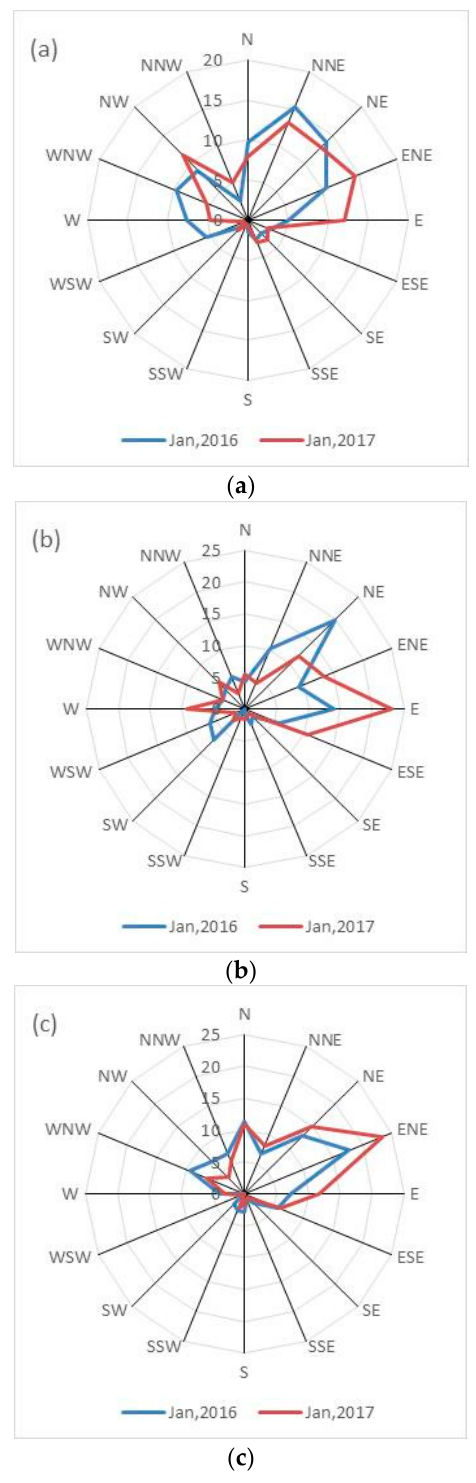
Figure 9. Wind rose in January of 2016 and 2017 in ( a ) Shanghai, ( b ) Nanjing, ( c ) Hangzhou.